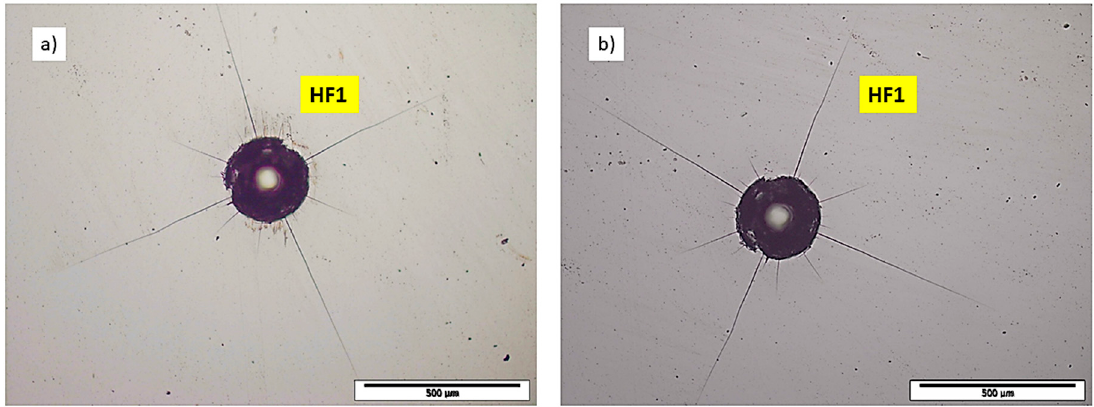
Figure 22. Coating surface around indentation and corresponding adhesion class of coated sample: ( a ) SH-5-TiBN; ( b ) SH-15-TiBN.